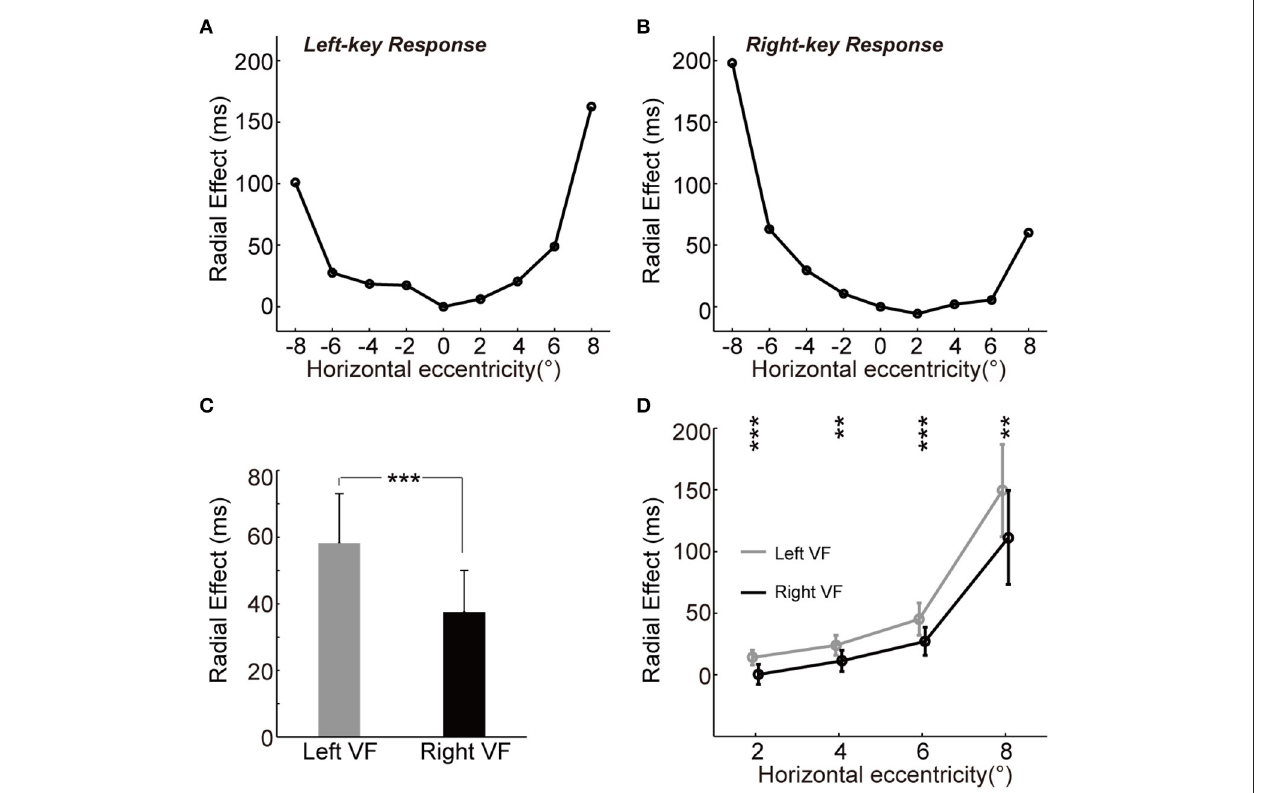
FIGURE 3 | The asymmetry of radial effect. (A,B) Tuning curve of the radial effect. The curve (through circles) represents the average of RT differences between two groups with left-key (A) and right-key (B) responses. (C) The radial effect between left and right VFs. (D) The radial effect between left and right VFs across each tested horizontal eccentricity. The gray curve (through gray circles) and black curve (through black circles), respectively represent the average of the radial effect in left and right VFs across each tested horizontal eccentricity. All the error bars denote ± SD. Asterisk denotes the results of paired t -test: ** p < 0.01; *** P < 0.001.